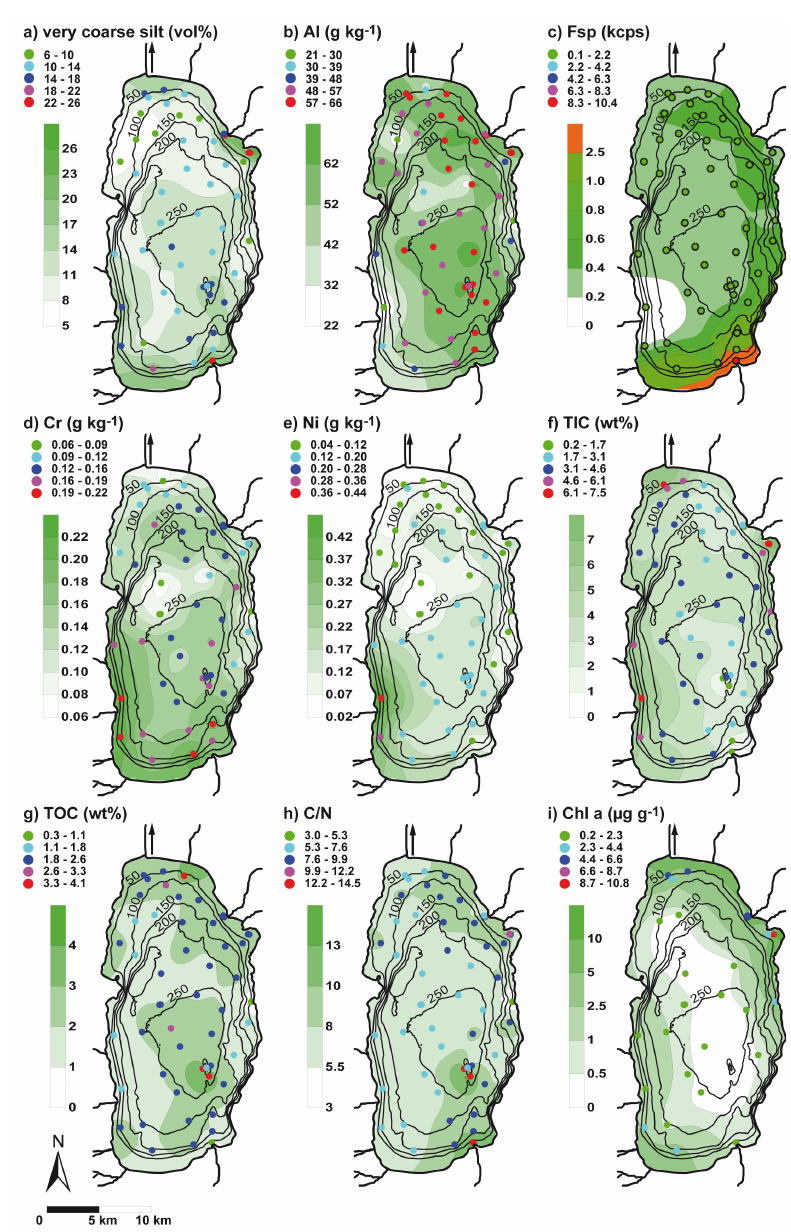
Fig. 3. Interpolated spatial distribution maps showing the concentrations of very coarse silt (a) , Al (b) , feldspar (Fsp; (c) ), Cr (d) , Ni (e) , total inorganic carbon (TIC; (f) ), total organic carbon (TOC; (g) ), total organic carbon organic nitrogen ratio (C/N; (h) ), and chlorophyll- a (Chl- a ; (i) ) in surface sediments of Lake Ohrid. Isopleths are interpolated using kriging and the interpolation program (SURFER v. 8). The dot legend shows sampling site specific concentration ranges and the column legend interpolated